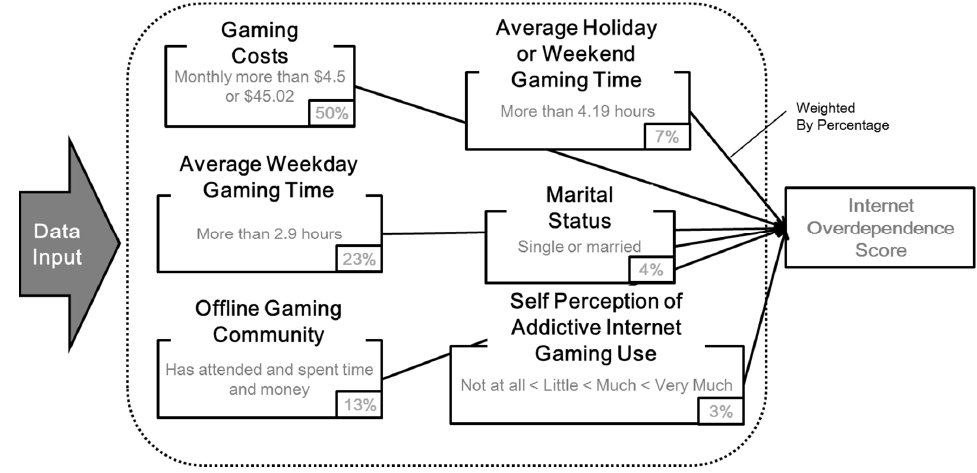
Figure 2. Smartphone overdependence decision algorithm.